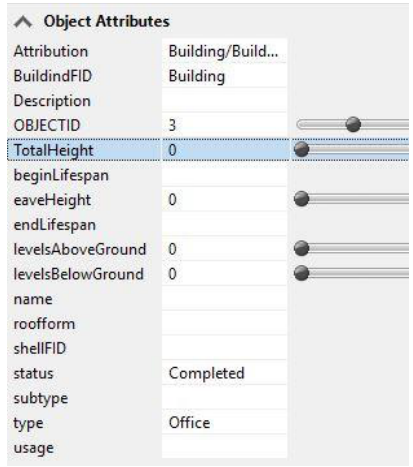
Figure 10: The attributes of the building footprint Since CityEngine incorporates the Procedural modeling approach for creating 3D models, a rule is necessary. The rule repetitively applied, will create the facade of the model. At first the rule is used to extrude the building model to the appropriate height value and then the faces of the model are separated, as shown in figure 11. To each face of the building the appropriate attributes are stored in the Object Attributes field according to the fields of the BuildingShellParts feature class of the 3DCIM, as presented in figure 12. At this point, also, the roof and the ground surface of the building are diverged from the wall surfaces.